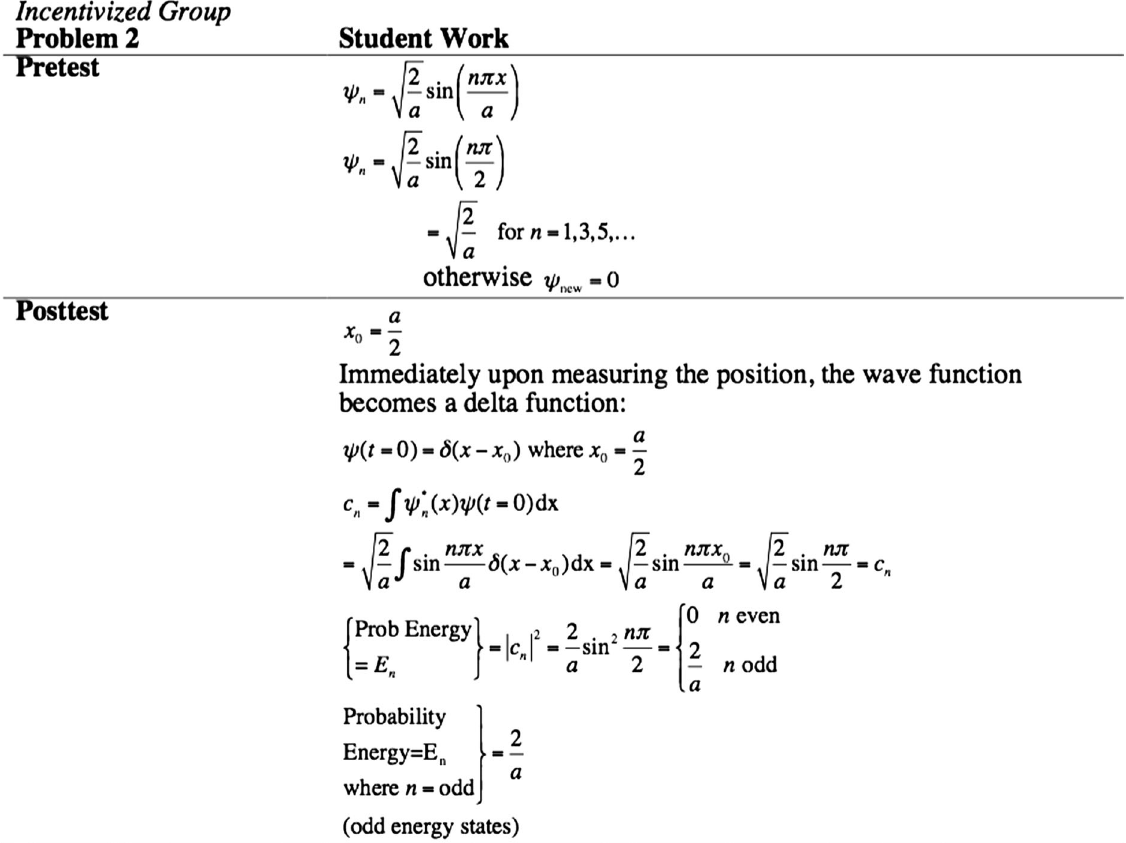
FIG. 8. An example of a pretest and posttest solution pair for a student from the incentivized group which demonstrates improvement in student understanding for the measurement problem. The pretest and posttest scores are 0% and 100% for invoking, 25% and 100% for applying, and 13% and 100% for the overall scores, respectively. The pretest solution shows that the student incorrectly inserts x ¼ a= 2 in the expression for the energy eigenfunction instead of calculating the probability of measuring energy. The posttest solution is essentially